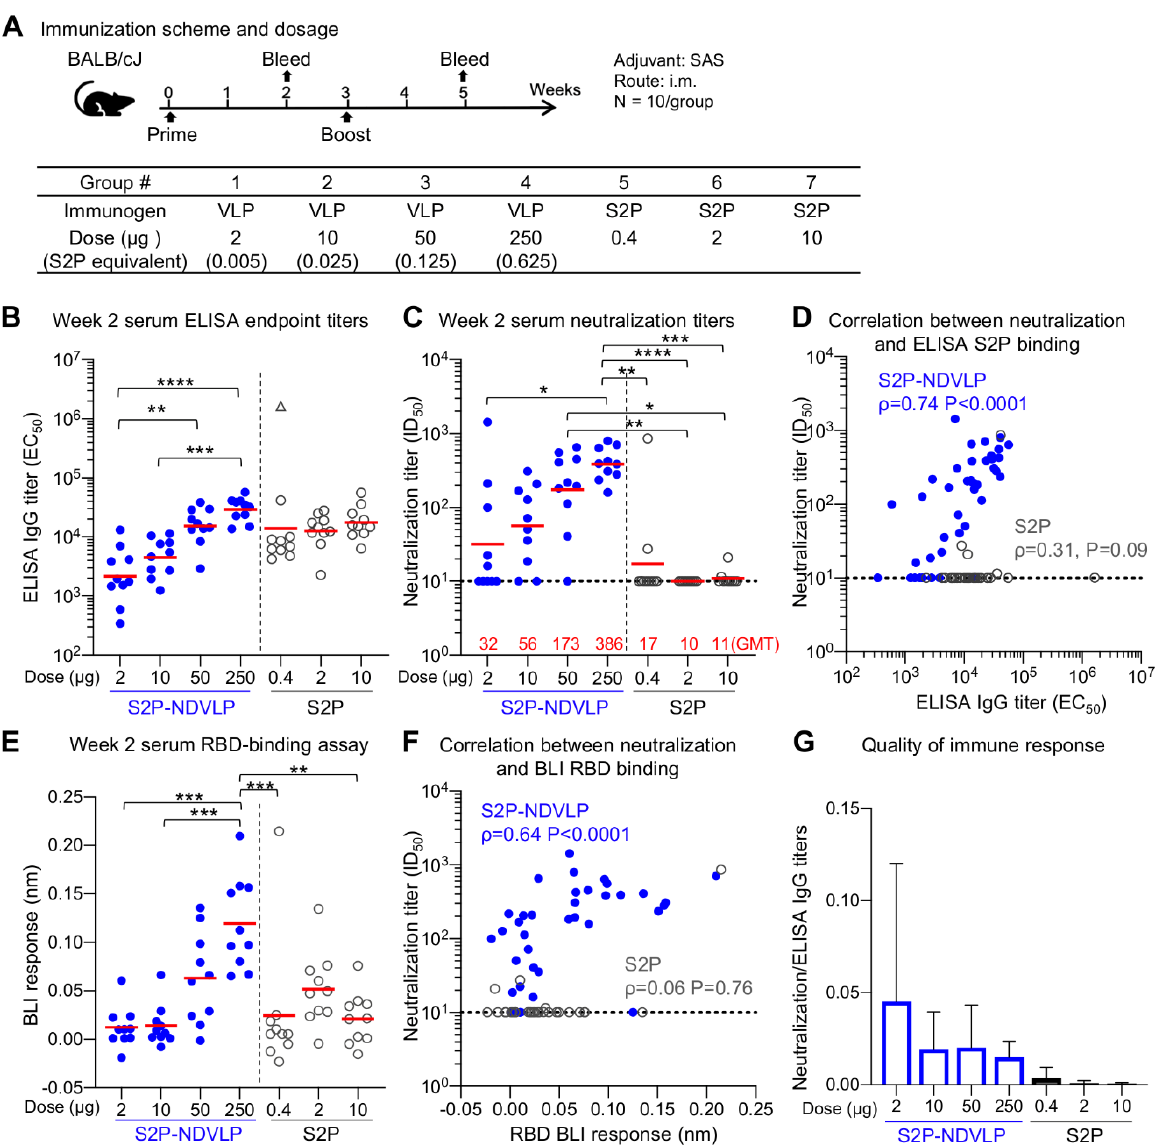
Figure 3. Single immunization of S2P-NDVLP elicited a high immune response against SARS-CoV-2 virus in mice at Week 2. ( A ) Scheme of the immunization regimen and groups. The control immunogen was a trimeric spike S2P glycoprotein. The amount of S2P in the S2P-NDVLP immunogen was quantified by Western blotting with S2P-immunized mouse sera (see Figure S2). ( B ) S2P-NDVLP elicited substantial IgG titers against the SARS-CoV-2 spike at Week 2. The endpoint IgG titers were measured, and EC 50 values were calculated as the readout for ELISAs with Prism. The triangle symbol indicates the ELISA titer at assay maximum. ( C ) S2P-NDVLP elicited substantial SARS-CoV-2 pseudovirus neutralization titers at Week 2. Serum-neutralizing antibodies against a D614G pseudovirus were measured, and ID 50 values were calculated as the readout of the neutralization assay with Prism. The geometric mean titer (GMT) of each group is marked in red numbers on the horizontal axis. ( D ) Correlation between neutralization titers and ELISA S2P-specific IgG titers existed in the S2P-NDVLP-immunized groups but not in the S2P-immunized groups. ( E ) RBD-specific serum antibody titers were measured as BLI responses and calculated with Prism. The titers among the S2P-NDVLP-immunized groups were dose dependent at Week 2. ( F ) Correlation between neutralization titers and BLI RBD-specific antibody titers existed in the S2P-NDVLP-immunized groups but not in the S2P-immunized groups. ( G ) Quality of immune responses elicited by immunization was calculated as the ratio of neutralization titer to total ELISA IgG titer, plotted as mean and SD. The